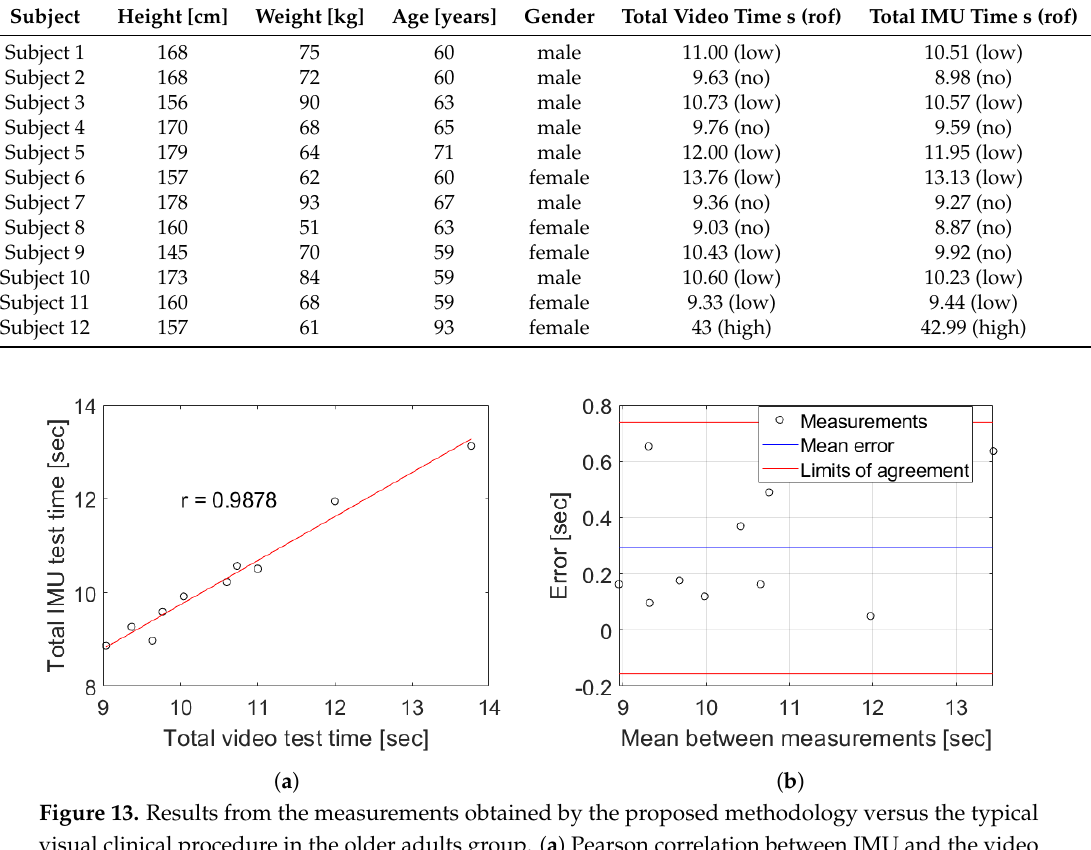
Figure 13. Results from the measurements obtained by the proposed methodology versus the typical visual clinical procedure in the older adults group. ( a ) Pearson correlation between IMU and the video record analysis without the high risk of falling subject; ( b ) Bland–Altman plot between IMU and the video record